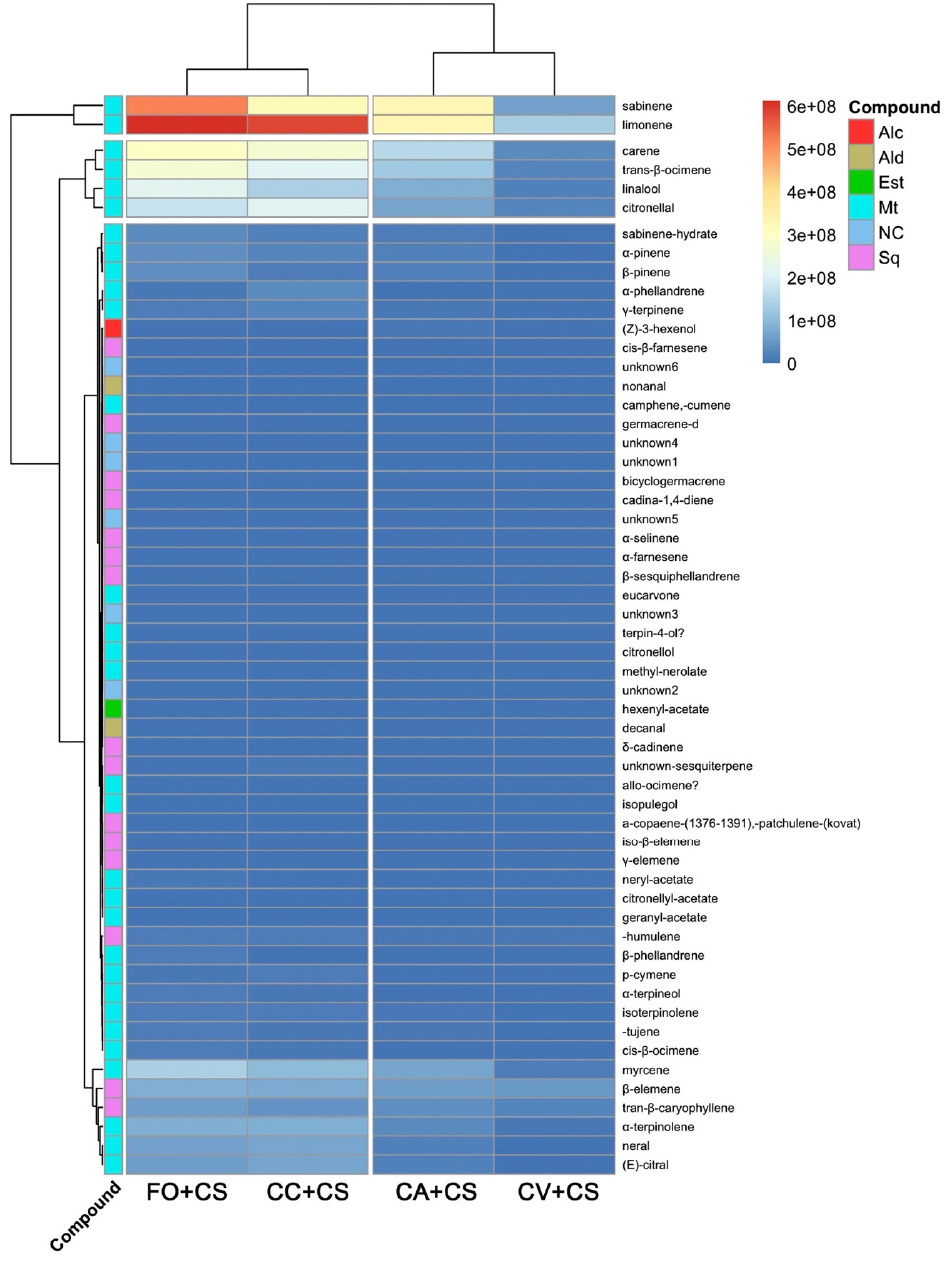
Figure 3. Heatmap on VOC emission of Citrus sinensis (CS) leaves grafted on Volkamer lemon (CV), Forner-Alcaide no. 5 (FO), Carrizo citrange (CC), and Citrus aurantium (CA). Alcohol (Alc), aldehydes (Ald) esters (Est), monoterpene (Mt), and sesquiterpene (Sq). NC: not classified—unknown. The heatmap legend (right) indicates the abundance (low—blue; high—red) of metabolites recorded in each sample.